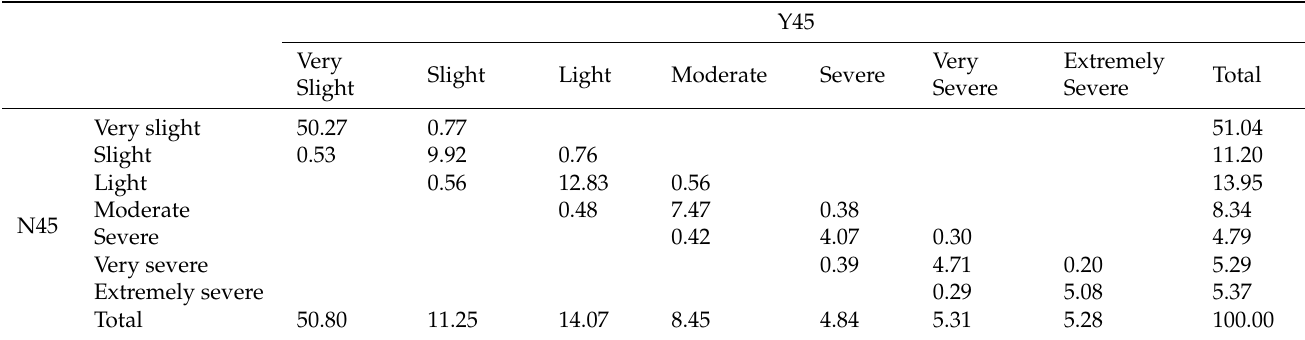
Table 4. Soil erosion transfer matrix with and without irrigation under RCP4.5